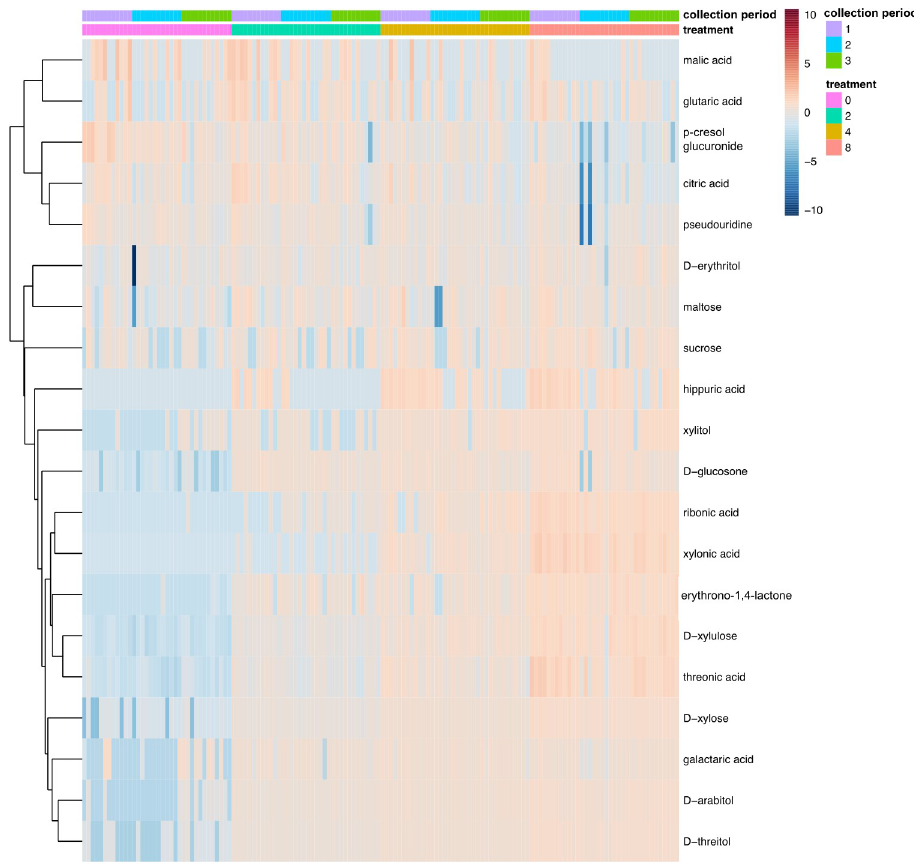
Fig 1. Two-way heat map visualization and hierarchical clustering of urine metabolite distribution. Pigs (n = 12/ treatment) were fed diets containing either 0, 2, 4, or 8% D-xylose and 3 different collection periods were utilized to represent increasing adaptation time to treatment diets. The rows display the metabolites and the columns represent individual samples. Relative urinary metabolite excretion (g/d, log transformed) is represented in the heat map by colors, which correspond to the magnitude of difference when compared with the average value for the metabolite. Only metabolites significantly (adjusted P � 0.05) impacted by treatment (% dietary xylose inclusion; 0, 2, 4, or 8%), collection period (1 = d 5–7, 2 = d 12–14, 3 = d 19–21), or their interaction are displayed. Significance was determined using two-way